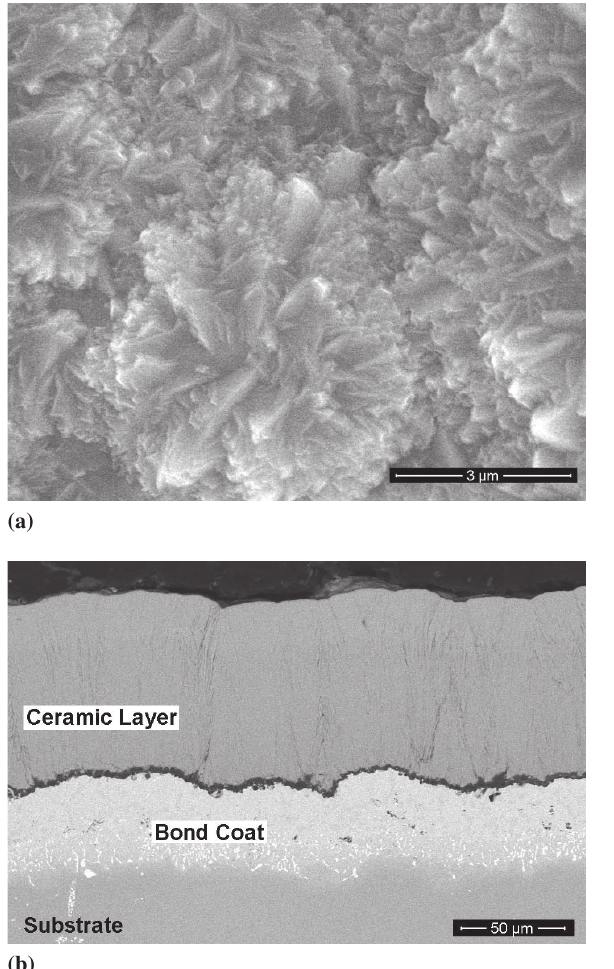
Figure 8. The typical 7YSZ coating deposited on a rotated sample (1000°C = 20 rpm): (a) surface morphology and (b) cross-sectional